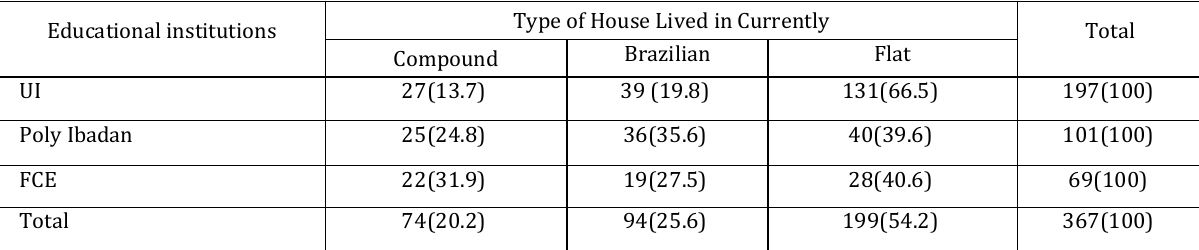
Table 8. Type of house currently lived in (source: Authors’ fieldwork data analysis, 2016)